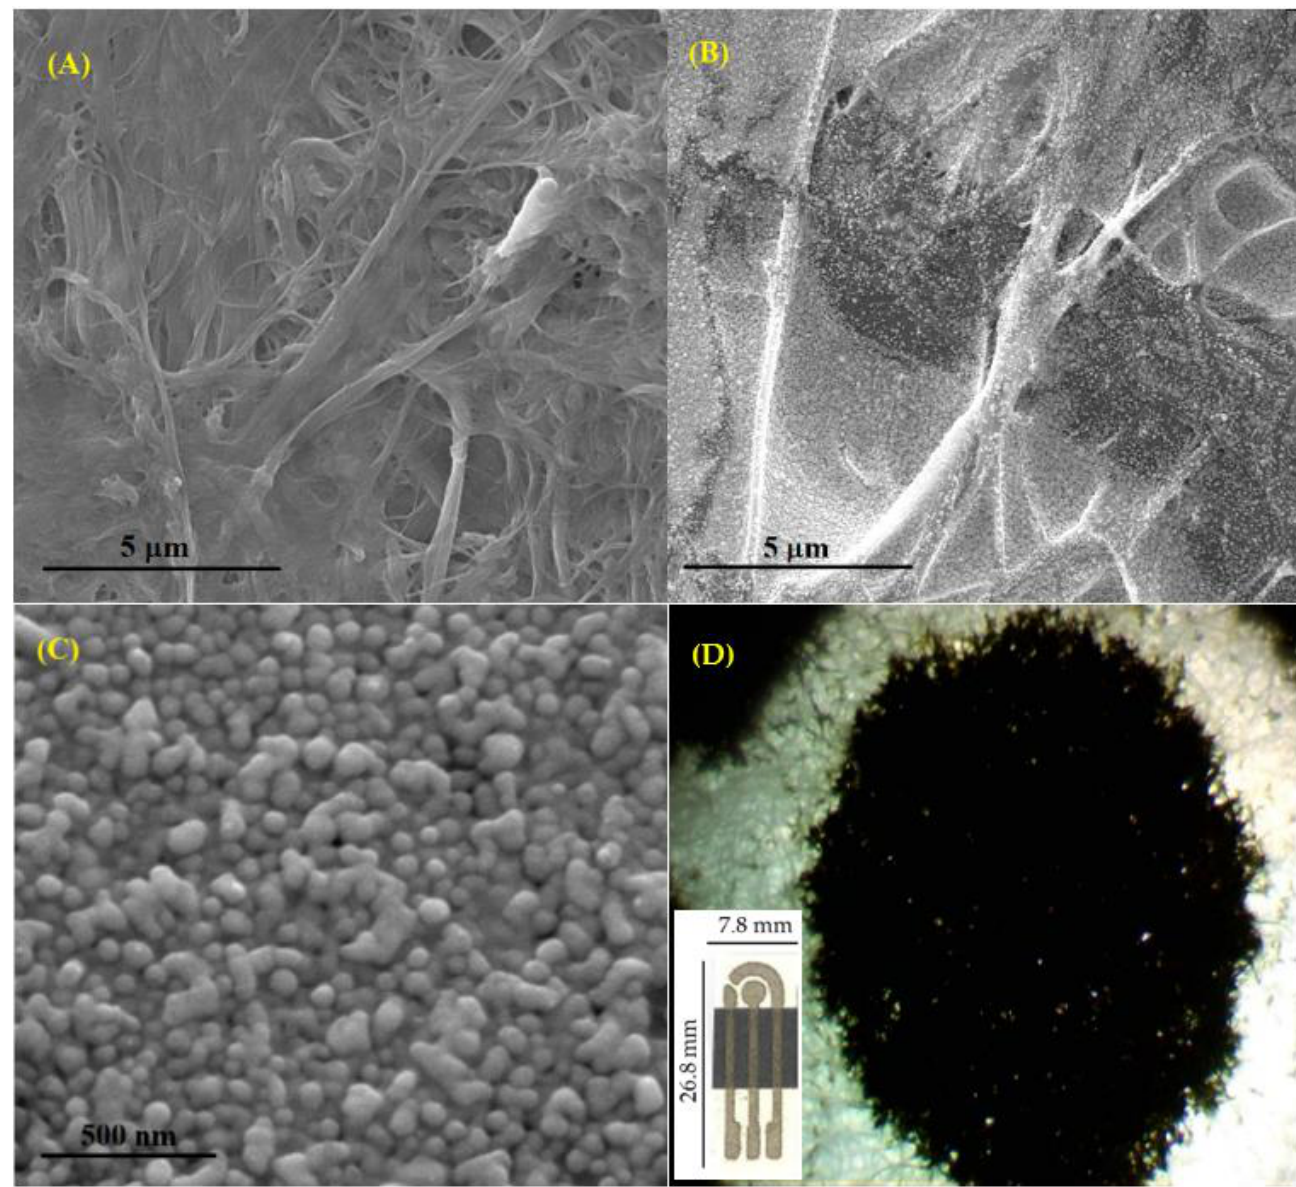
Figure 1. SEM images obtained from the ( A ) bare paper and ( B , C ) silver electrode surface printed on the paper substrate at different magnifications. Optical image ( D ) of the silver electrode. The inset is the photo of the three-electrode system.